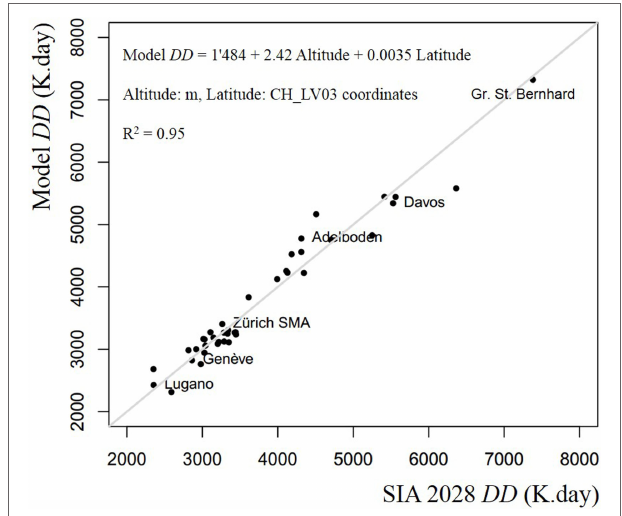
FIGURE 2 | Model degree day DD versus SIA 2028 DD for all Swiss meteorological